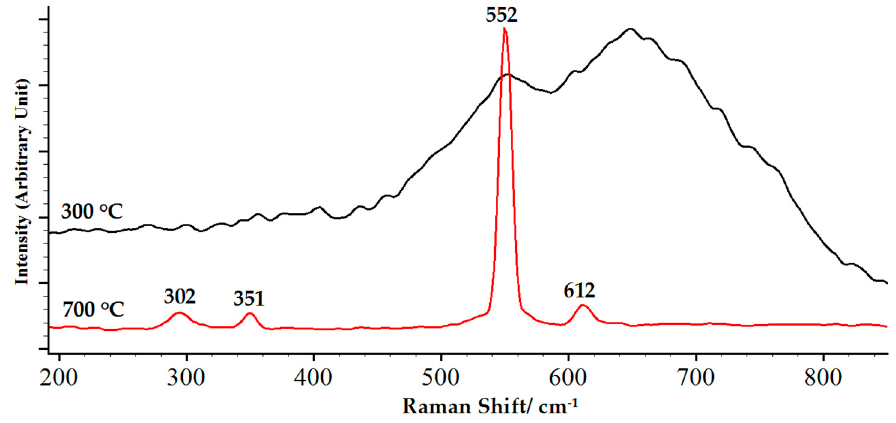
Figure 11. The effect of annealing temperatures on the crystal structure of hard chromium oxide coatings.